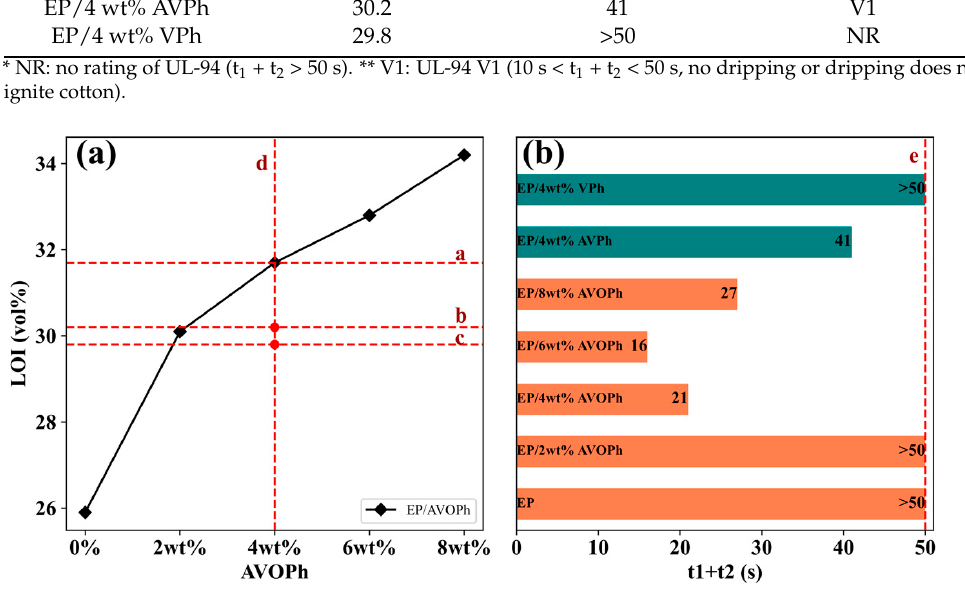
Figure 3. The LOI and vertical combustion curves of EP and EP composites: ( a ) LOI; ( b ) vertical combustion. a: the LOI of EP/4 wt% AVOPh. b: the LOI of EP/4 wt% AVPh. c: the LOI of EP/4 wt% VPh. d: additive ratio. e: V1: UL-94 V1 (10 s < t 1 + t 2 < 50 s, no dripping or dripping does not ignite co tt on).